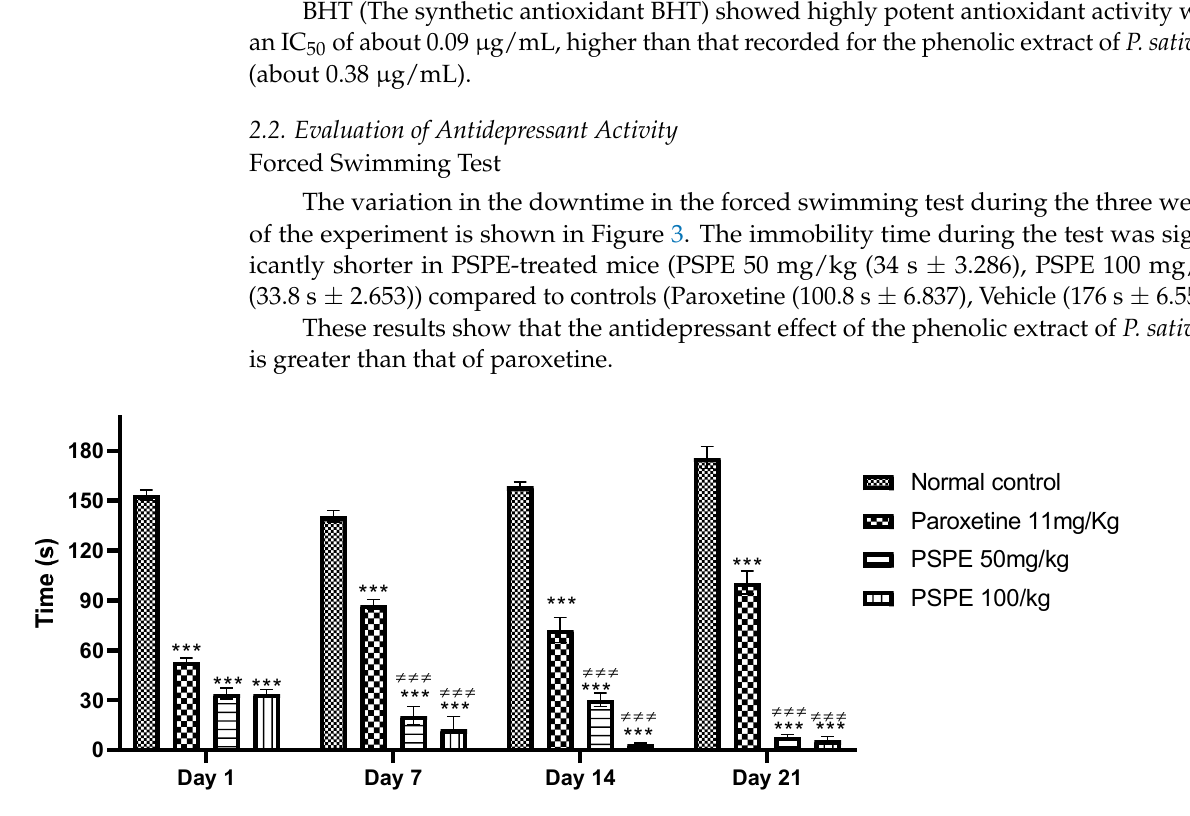
Figure 2. Antioxidant activity of PSPE during the FRAP test. PSPE: Polyphenolic fraction of P. sa- tivum , BHT: Butylated hydroxytoluene.